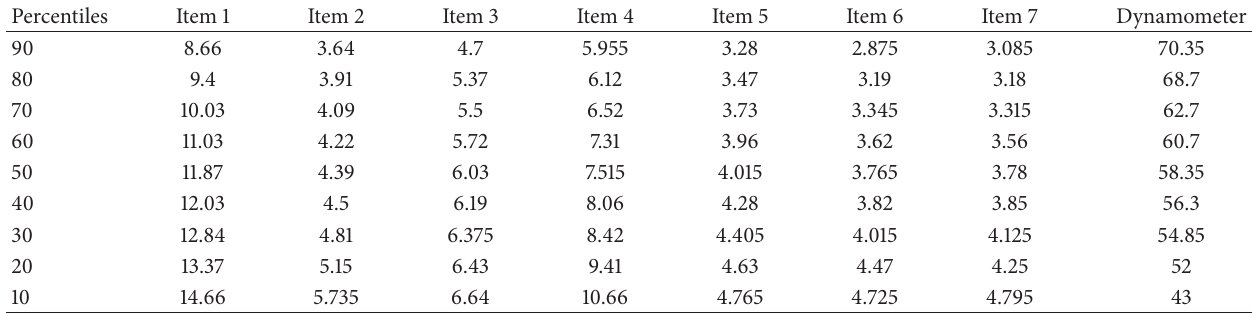
Table 22: 𝑛 = 34 , females, 20–94, dominant hand, educational instruction: degree.